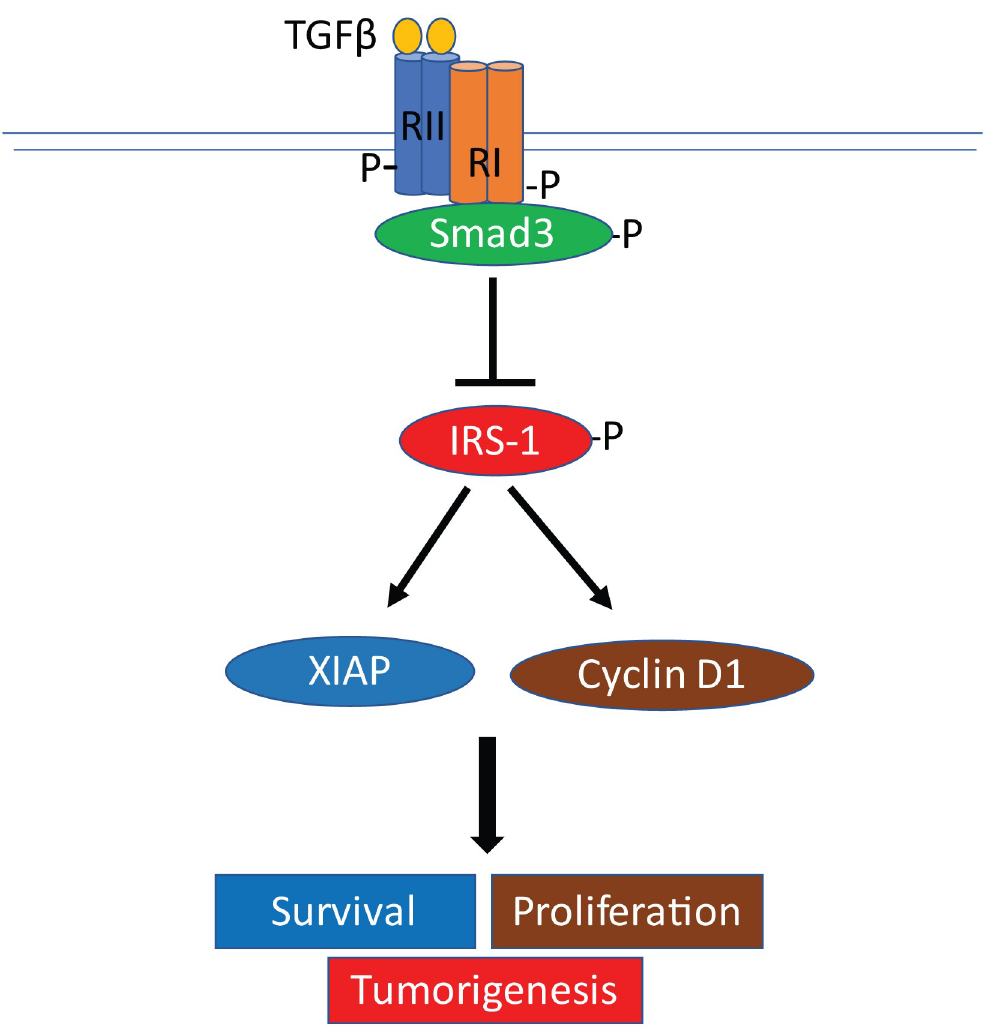
Fig 5. A proposed model of crosstalkbetween TGF β signaling and IRS-1 in the regulation of XIAP and cyclin D1 expression, cell survival, proliferation and tumorigenesis in colon cancer